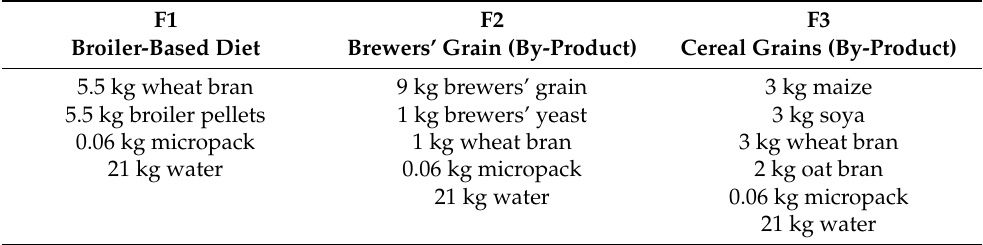
Table 1. Ingredient formulation for three different black soldier fly larvae